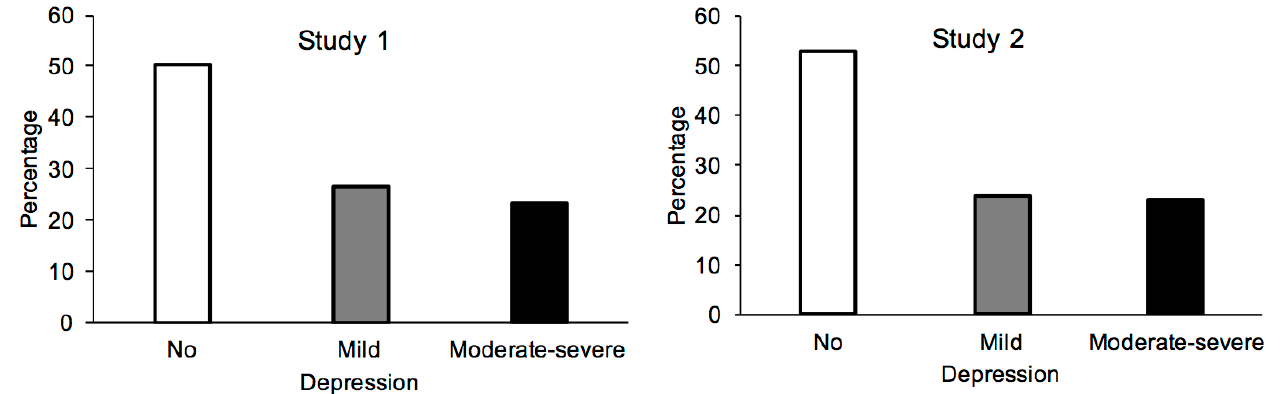
Figure 1. Severity of the depressive symptoms in Study 1 and Study 2.